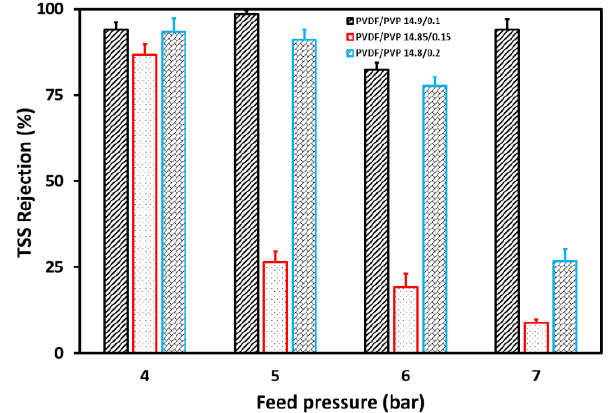
Figure 7. TSS rejection at various feed pressures in the UF process for tofu wastewater.